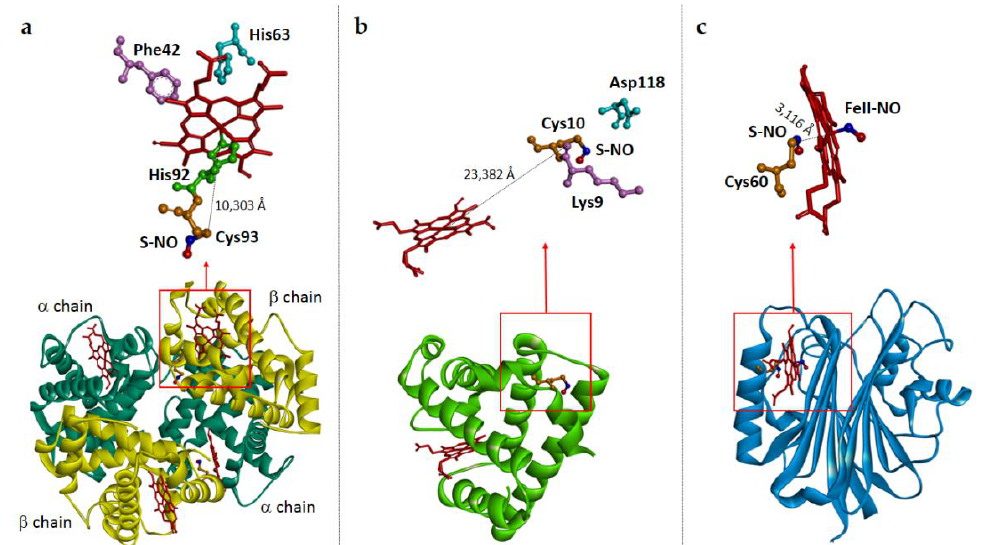
Figure 4. Three-dimensional structures of S-nitrosylated forms of ( a ) liganded human Hb (PDB 1BUW) with the α chains in cyan, and the β chains in yellow; ( b ) blackfin tuna Mb (PDB 2NRM) with the globin chain in green; ( c ) C. lectularius NP (PDB 1Y21) with the protein chain in blue. In all figures, the heme is in red; the binding of NO with Cys is highlighted in stick and balls with Cys in orange, NO in blue and red. In the enlargements, the heme and the residues relevant to S-nitrosylation are reported; the distance between the iron and the Cys is measured in Å .